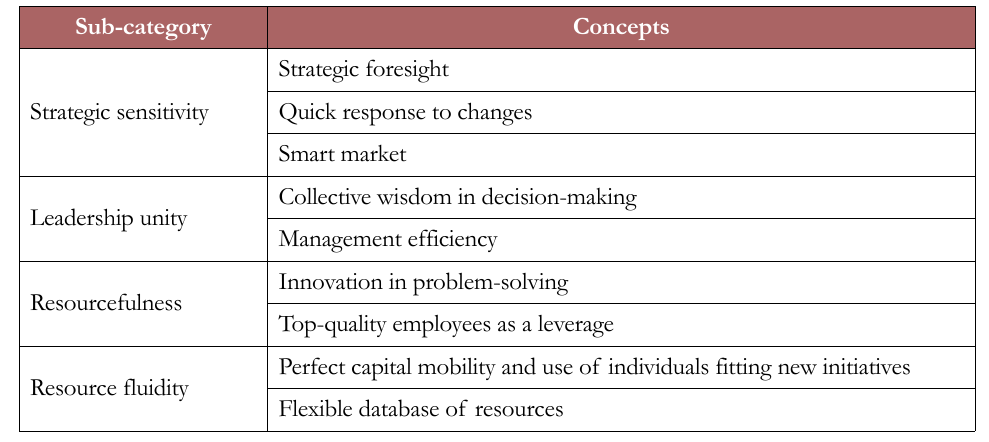
Table 6. Concepts and categories of core